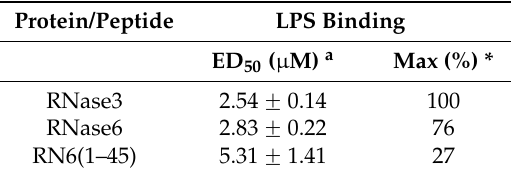
Table 2. LPS-binding affinity of RNase3, RNase6 and